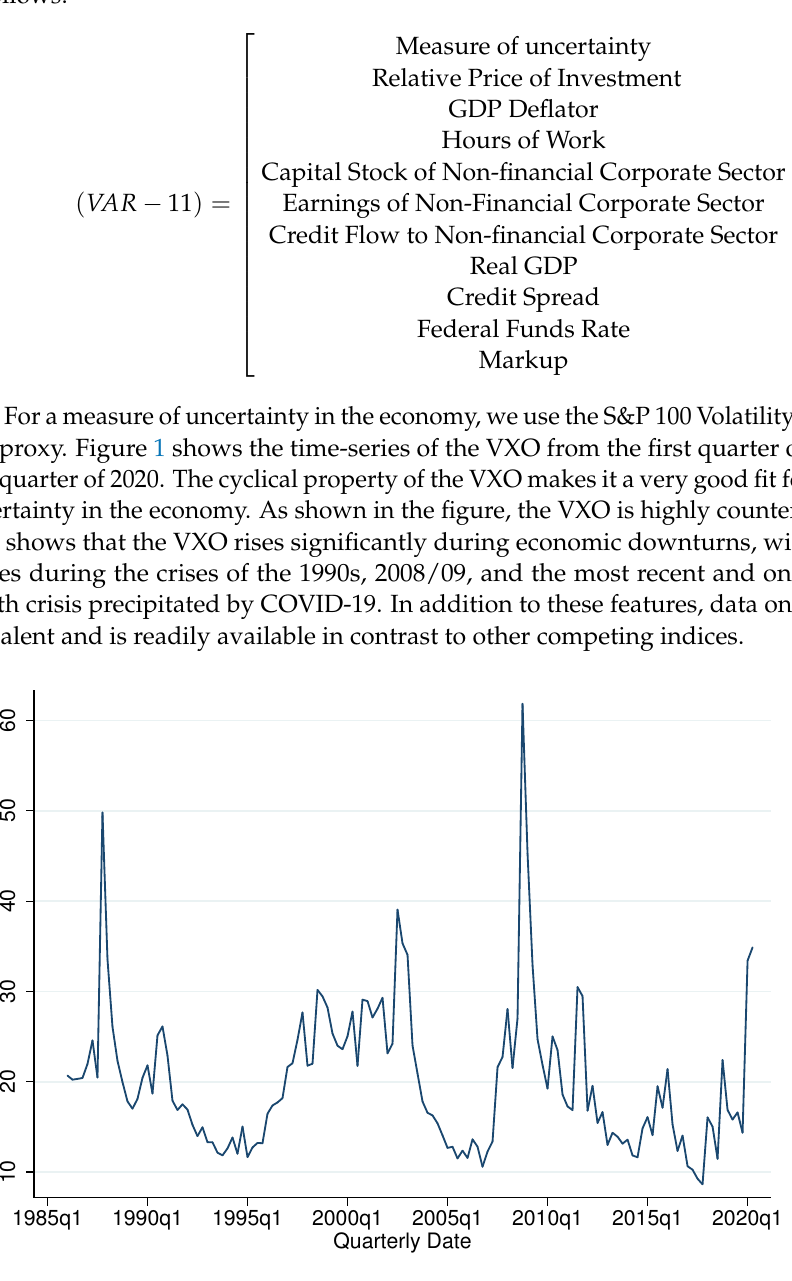
Figure 1. Time-Series of the VXO from 1986Q1 to